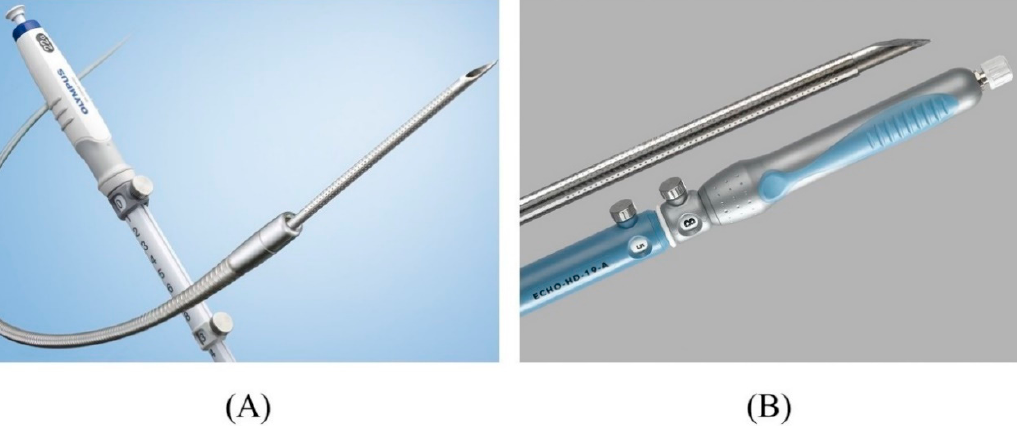
Figure 7. Needles suitable for EUS-HGS. EZ shot 3 plus (Olympus Medical Systems) has a nitinol needle with a coil sheath (Courtesy of Olympus Medical Systems) ( A ). EchoTip Access Needle (Cook Medical) has a sharp stylet and blunt-tipped needle (Courtesy of Cook Medical) ( B ).